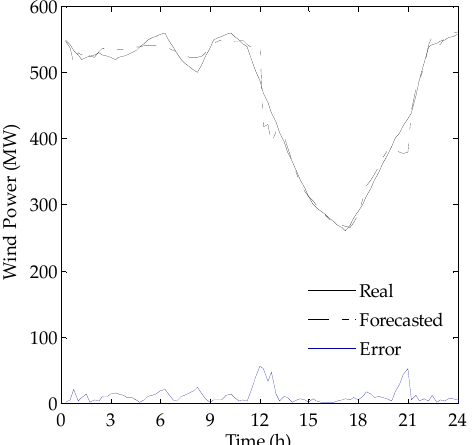
Figure 15. Real and forecasted wind power results (15 ‐ min intervals) for the Autumn day.